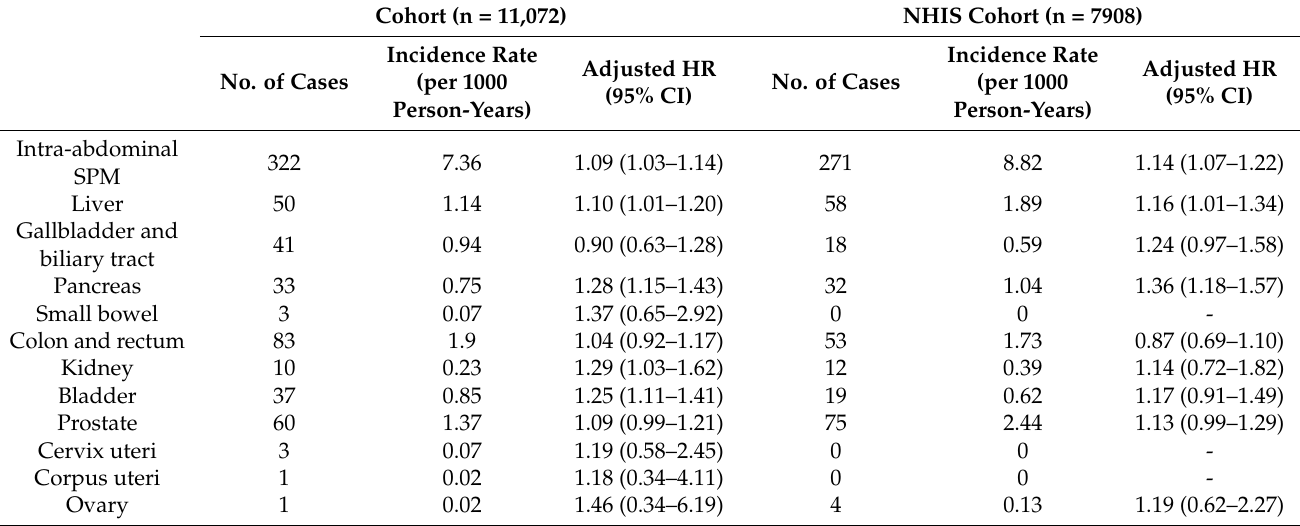
Figure 2. Ten-year cumulative incidence of intra-abdominal second primary malignancies following abdominopelvic computed tomography scans ≤ 8 versus >8. Table 3. Risk of SPM following abdominopelvic CT scans (continuous